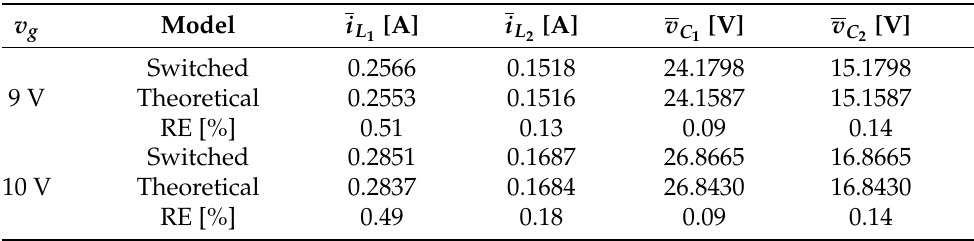
Table 8. Small signal results in ´Cuk converter without coupled inductors.